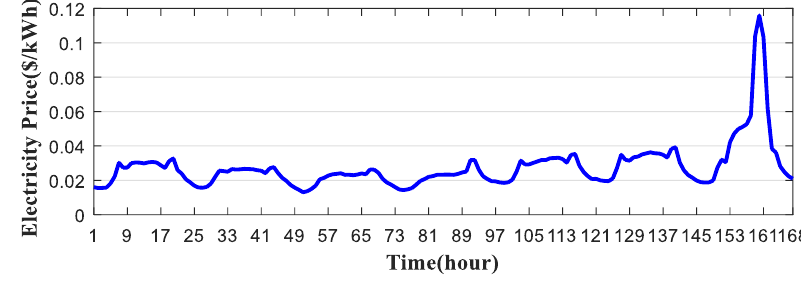
Figure 7. Forecast of water demand with different methods targeting data from GEFCom2014.